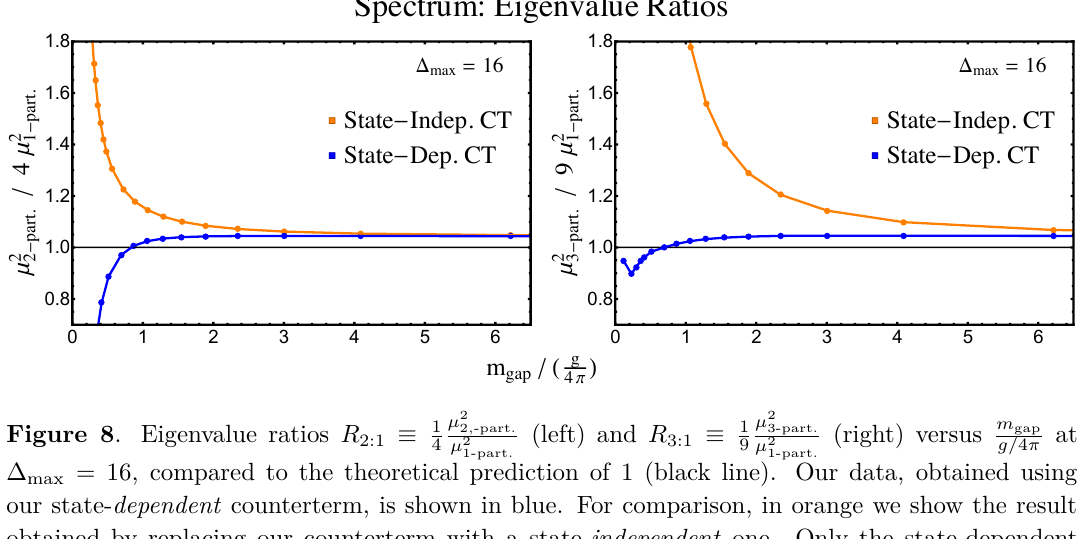
Figure 8 . Eigenvalue ratios R 2:1 ≡ 1 ∆ = 16 , compared to the theoretical prediction of 1 (black line). Our data, obtained using max our state- dependent counterterm, is shown in blue. For comparison, in orange we show the result obtained by replacing our counterterm with a state- independent one. Only the state-dependent counterterm yields reliable ratios in the nonperturbative regime m gap